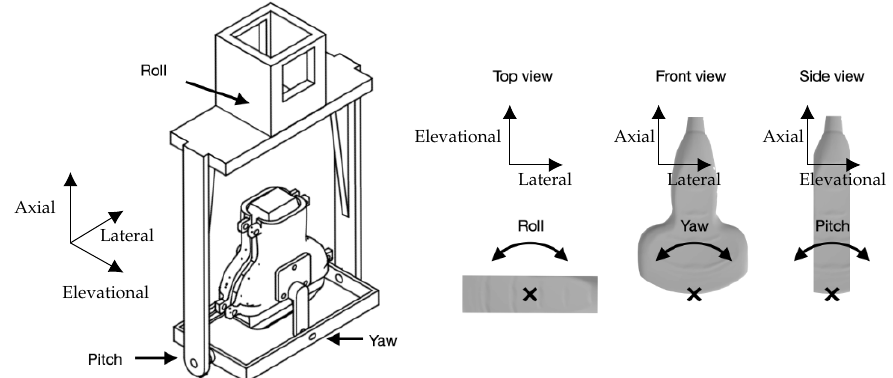
Figure 3. Drawing of the bespoke US probe mount allowing manual adjustment of the pitch, yaw and roll of the US